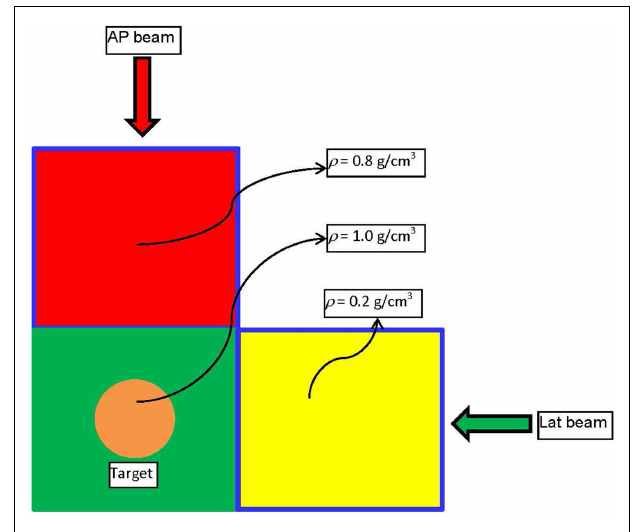
FIGURE 1 | Schematic diagram of the phantom and the beam arrangement used to demonstrate the basic physics principle of Energy-based inverse optimization .